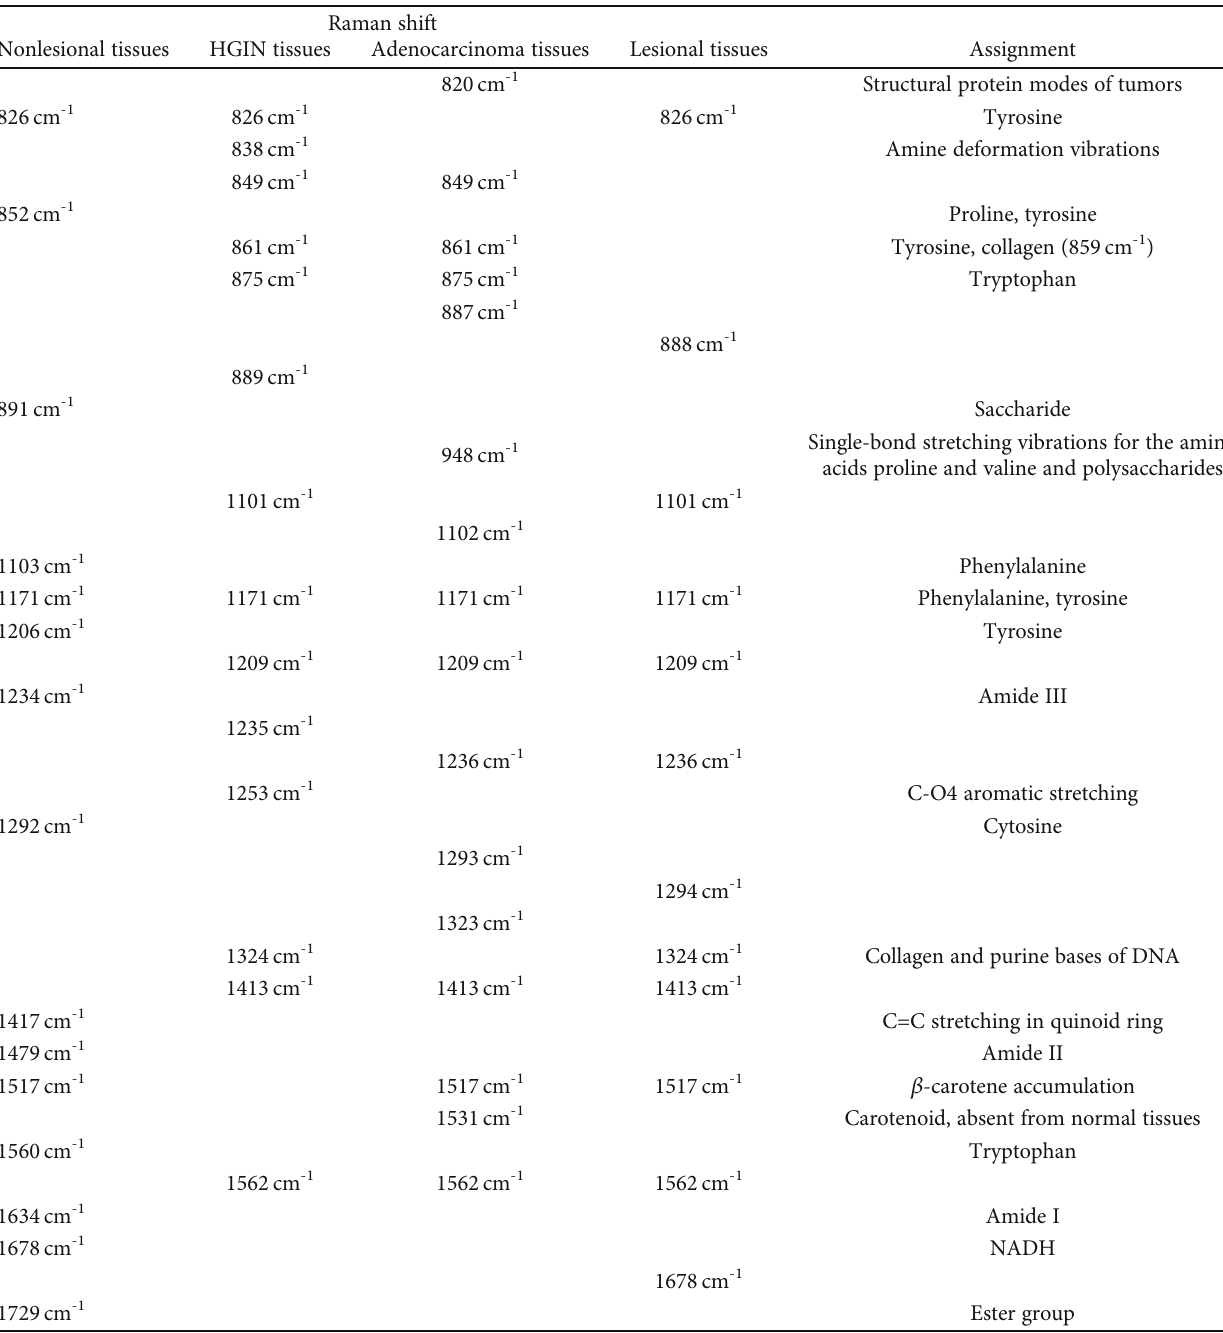
Table 1: Raman peak